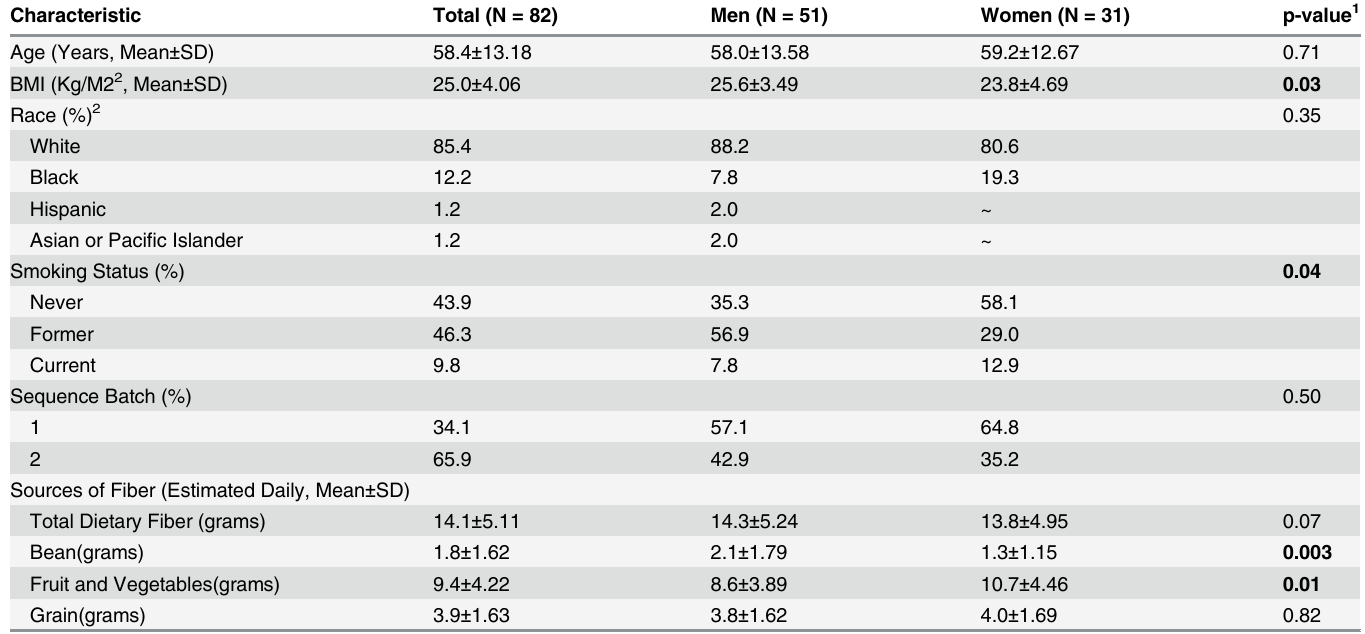
Table 1. Population